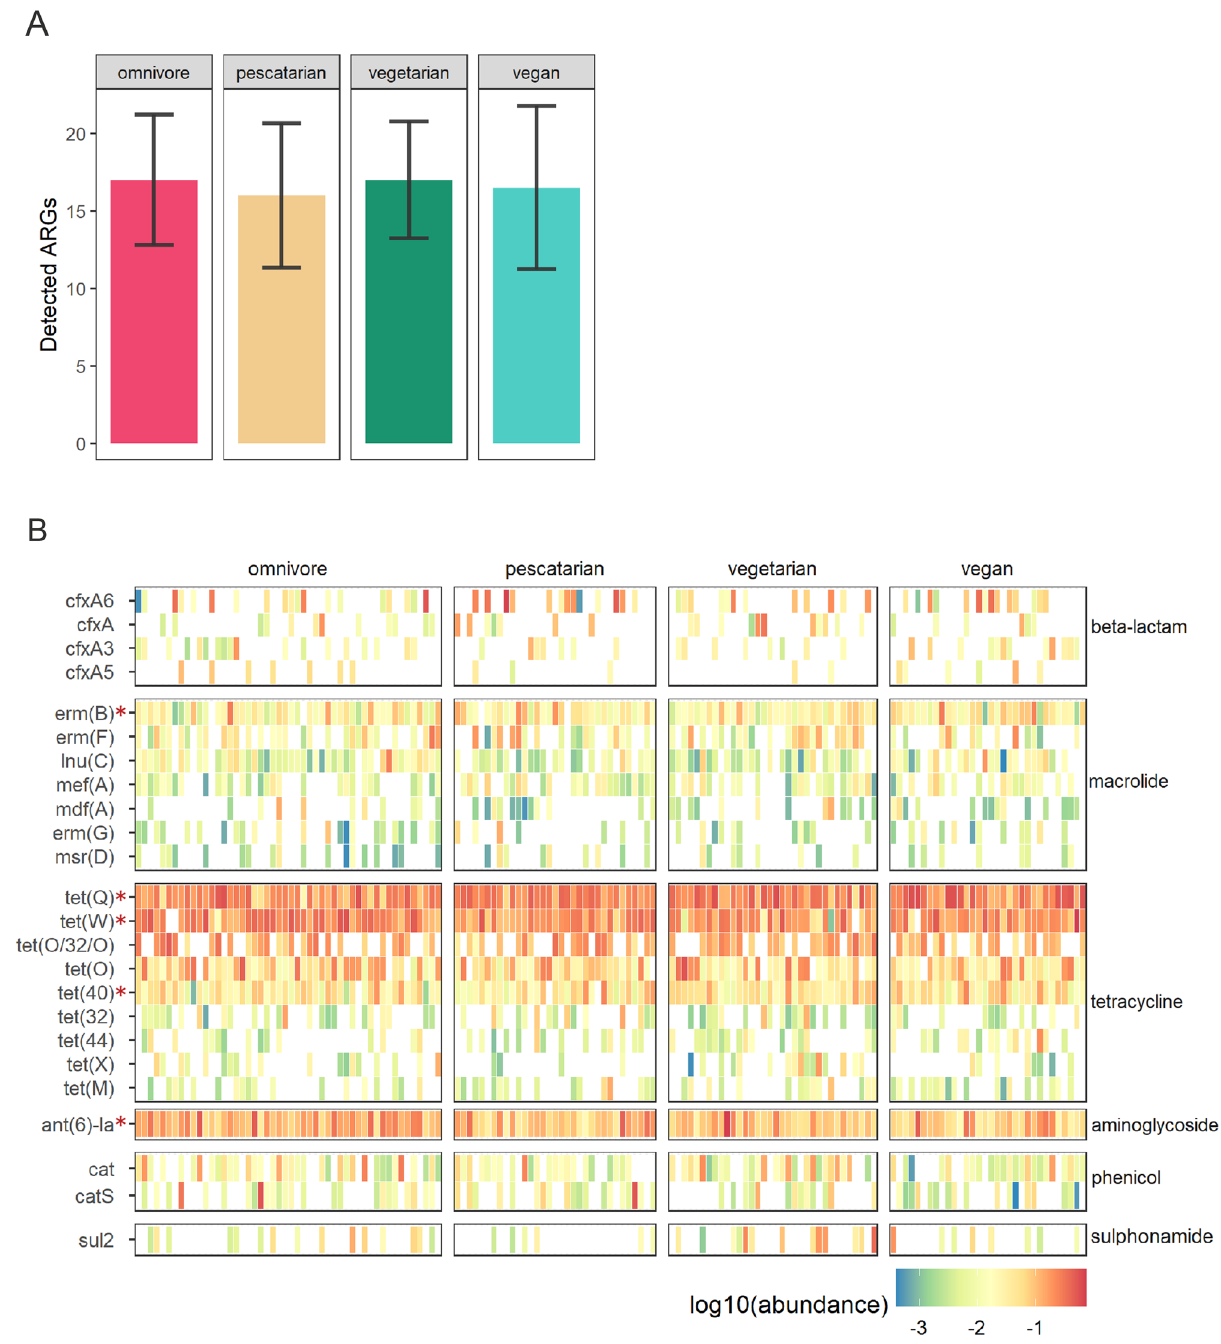
Figure 2. Antibiotic resistance gene distribution in the gut resistome through metagenomic shotgun sequencing. ( A ) Average number and standard deviation of antibiotic resistance genes (ARGs) detected in each diet group. ( B ) Heatmap depicting ARGs abundance per participant. Each column denotes a study participant, clustered per diet group. Rows represent the relative abundance of ARG classes. ARGs present at least in 10% of the participants are shown. ARGs present in the resistome of at least 95% of the participants are indicated by the